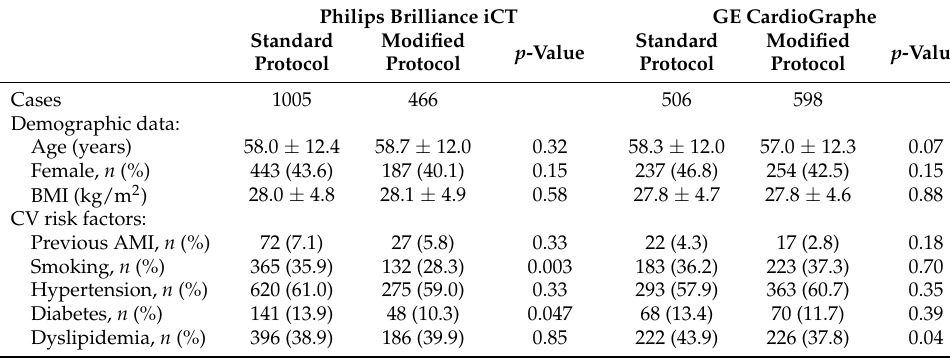
Table 1. Demographic parameters and cardiovascular risk profile of enrolled patients.